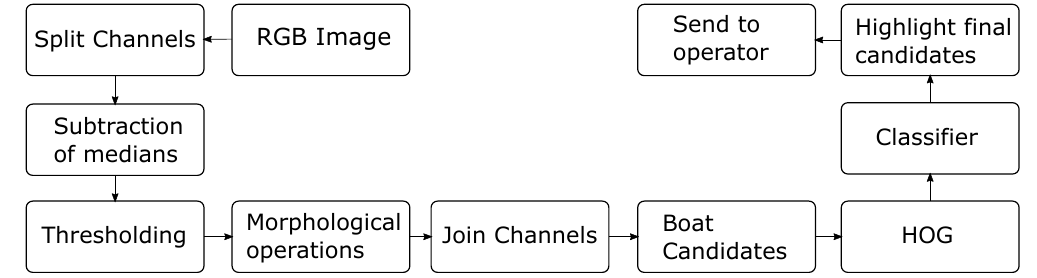
Figure 8. Sequence of steps of the proposed